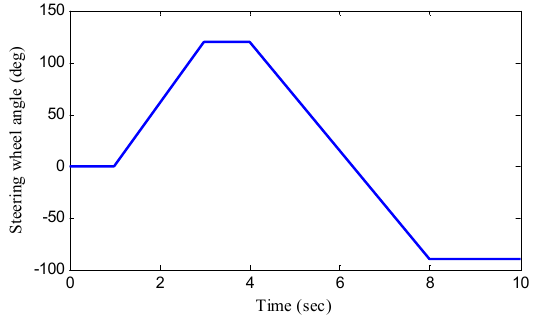
Figure 4. Fishhook maneuver.